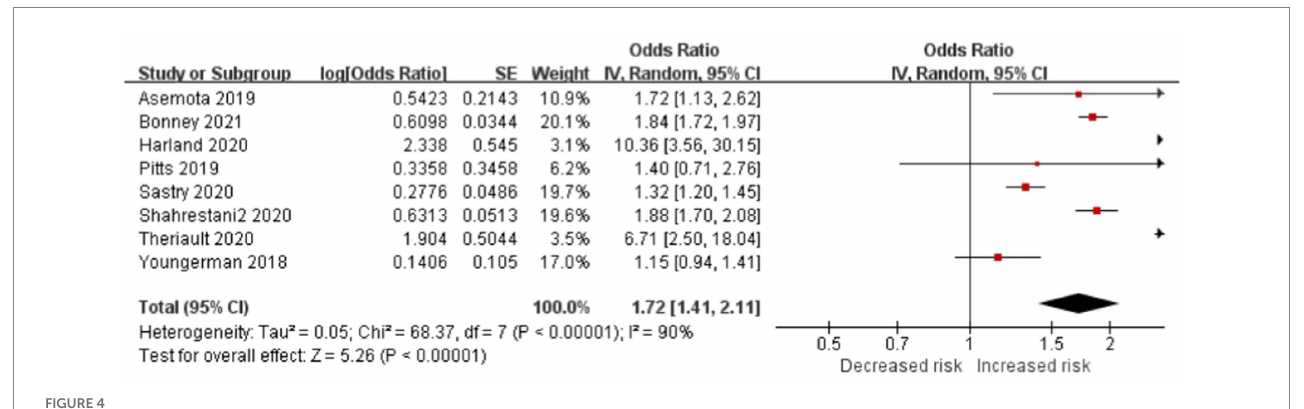
FIGURE 4 Forest plots presenting frailty is the risk of non-routine discharge disposition in brain tumor